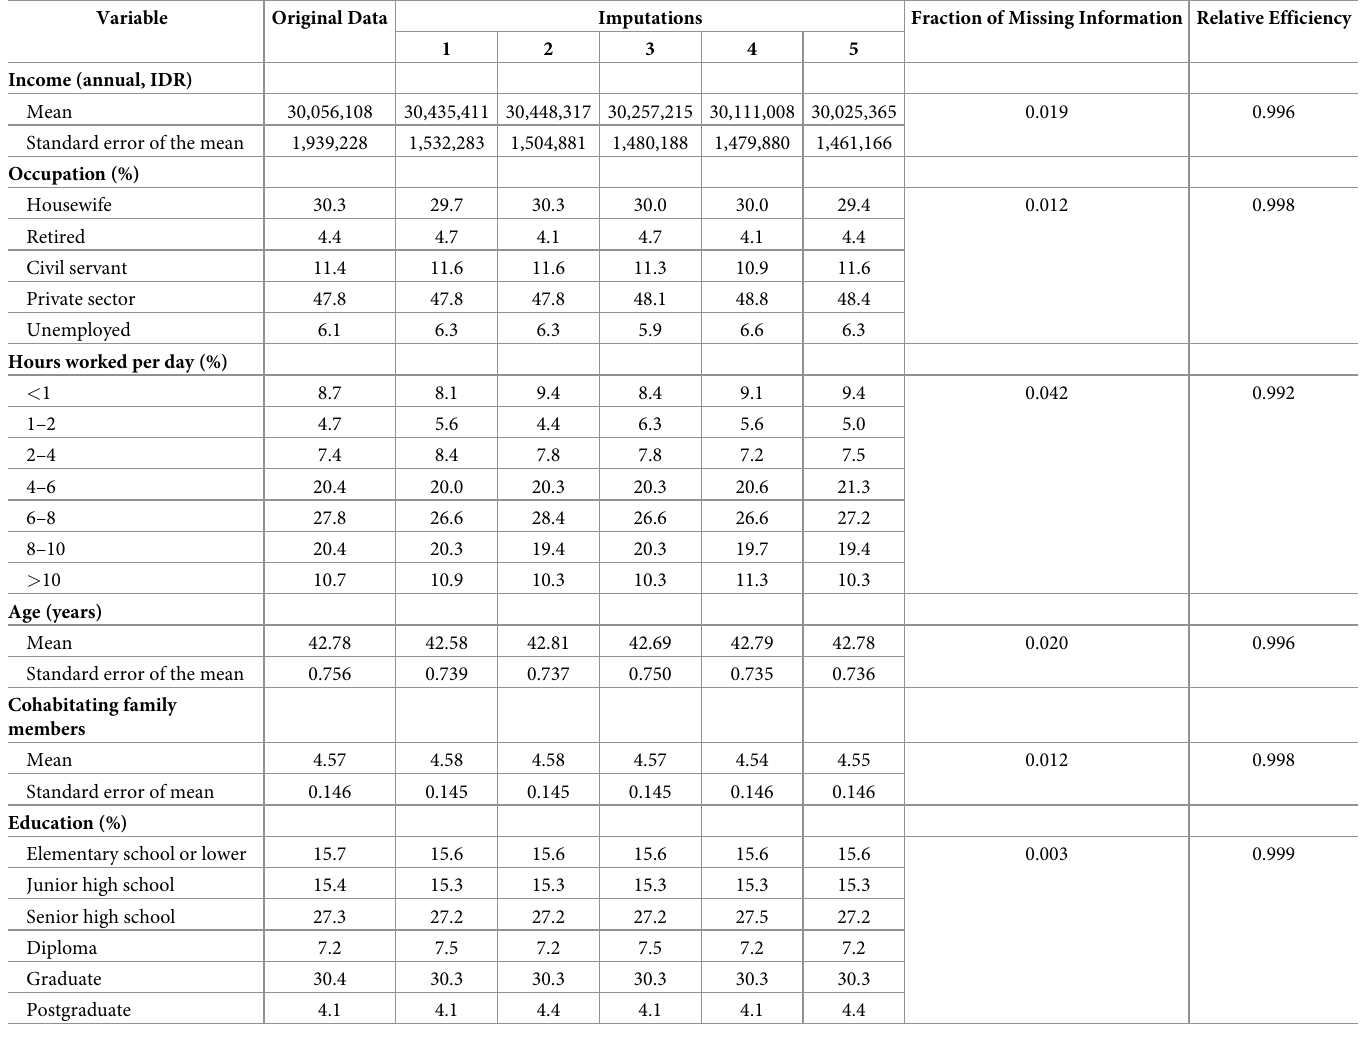
Table 2. Variables, including original data with missing data and after multiple